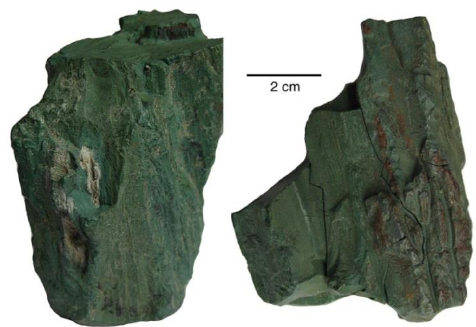
Figure 29. Permian wood replaced by volkoenskite, from Ural Mountains, western Russia. Photos courtesy of Mike Viney, used with permission.